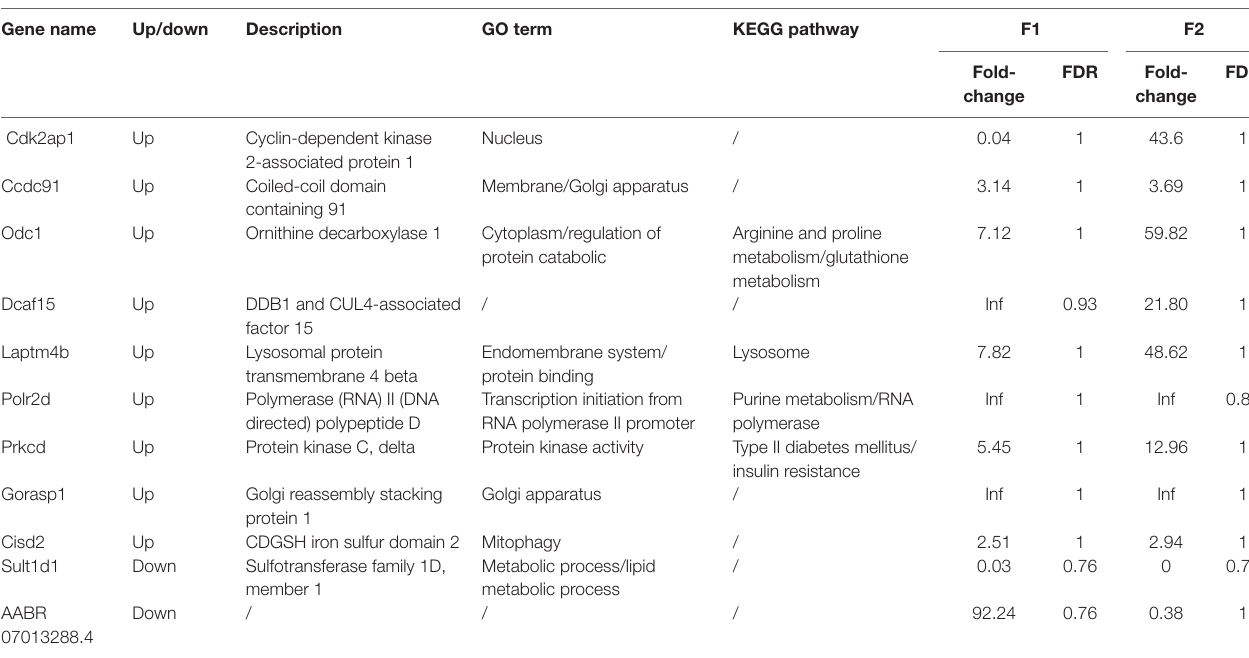
TABlE 2 | Heredity